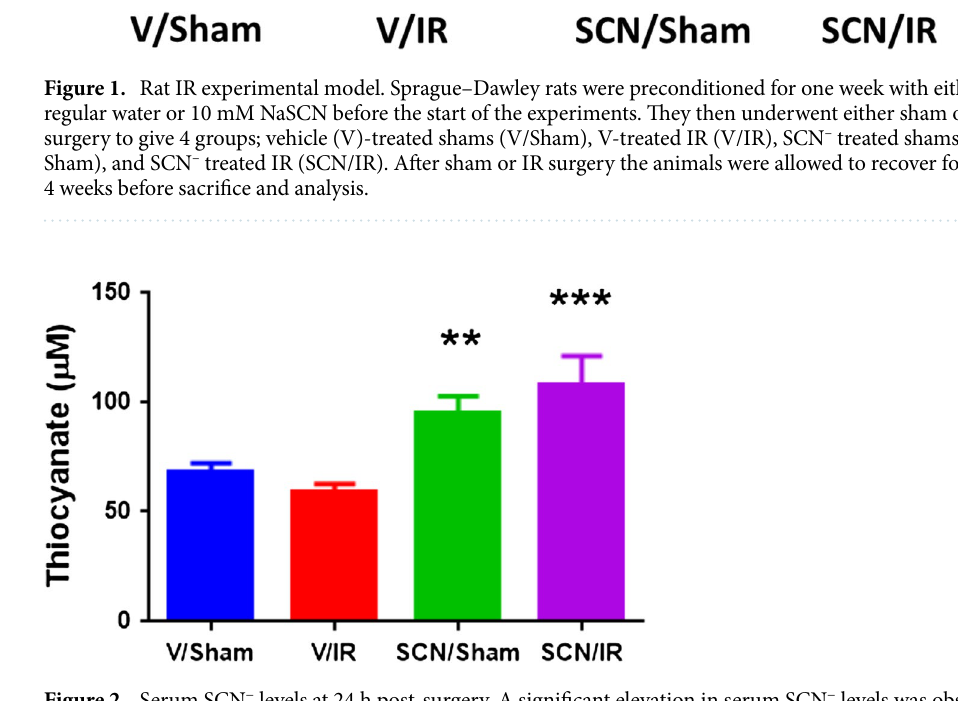
Figure 2. Serum SCN − levels at 24 h post-surgery. A significant elevation in serum SCN − levels was observed for both the SCN − -treated groups as determined by one-way ANOVA with a post-hoc Newman-Keuls Multiple Comparison Test, where ** = p < 0.01 and *** = p < 0.001, relative to the corresponding